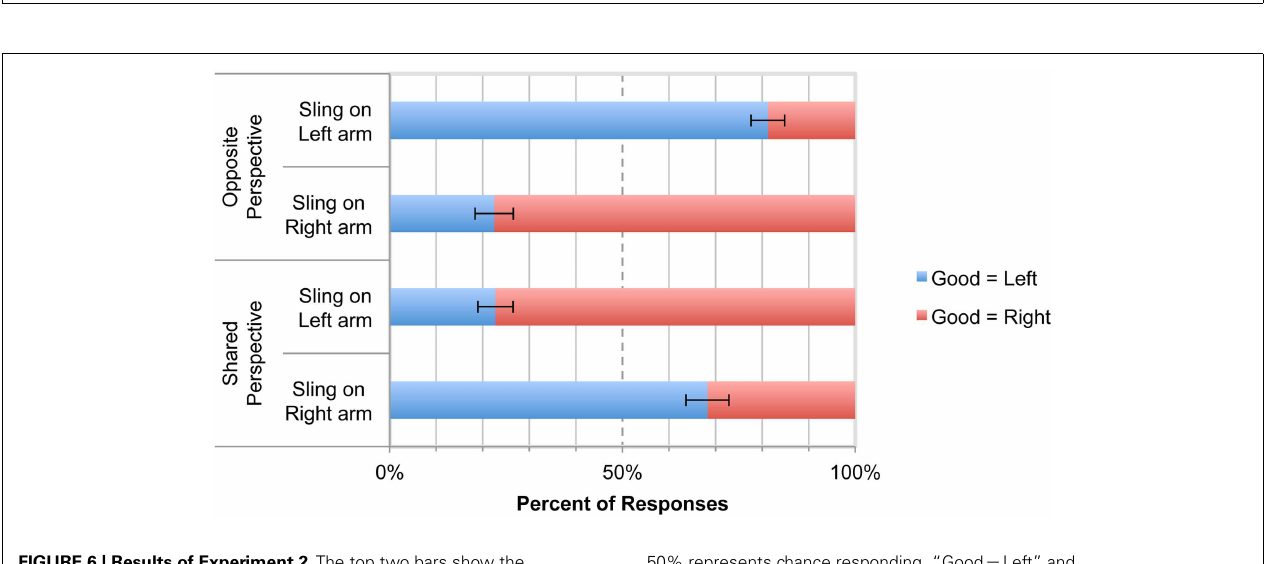
FIGURE 6 | Results of Experiment 2 .The top two bars show the results when the sling was on Bob’s left arm, and the bottom two bars show results when the sling was on Bob’s right arm.The dashed line at